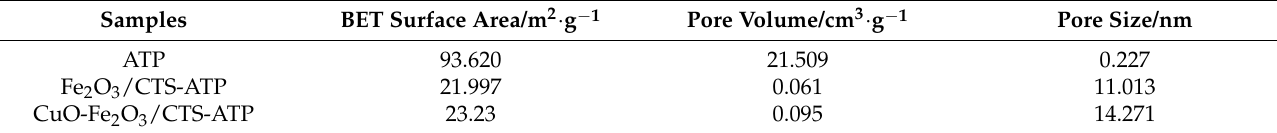
Table 1. BET measurement results of samples.